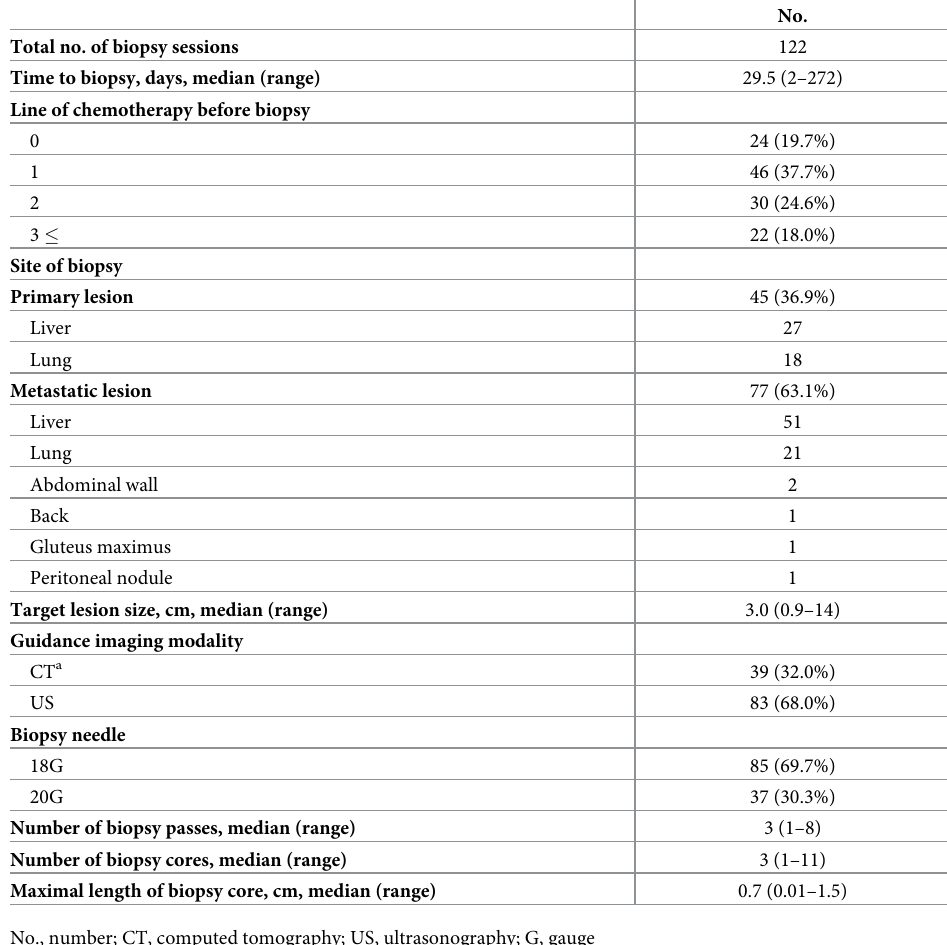
Table 2. Biopsy features.